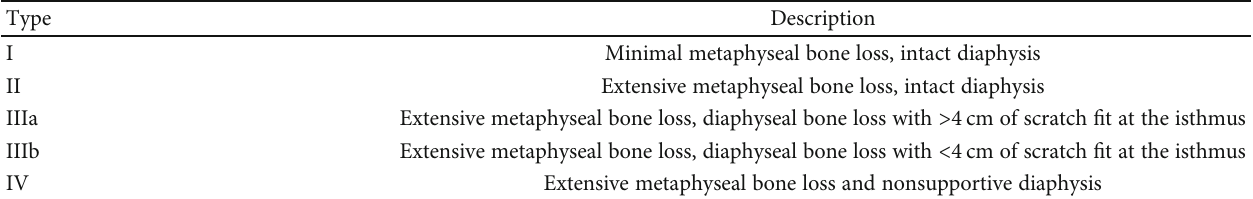
Table 1: Paprosky classi fi cation of femoral de fi ciency in rev1s1 on total hip